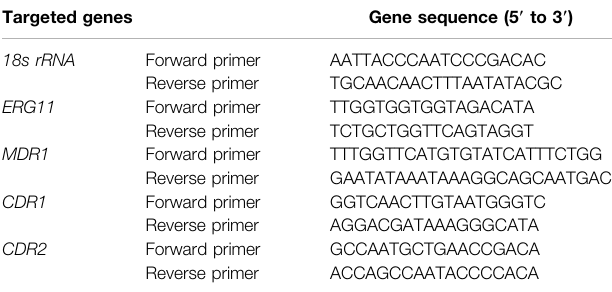
TABLE 2 | Primer sequences used in the RT-PCR